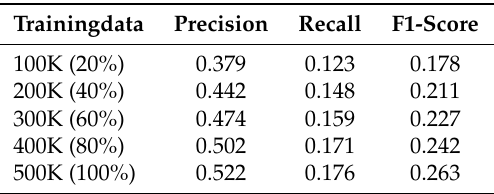
Table 6. The influence of number of training data in Zhihu dataset.